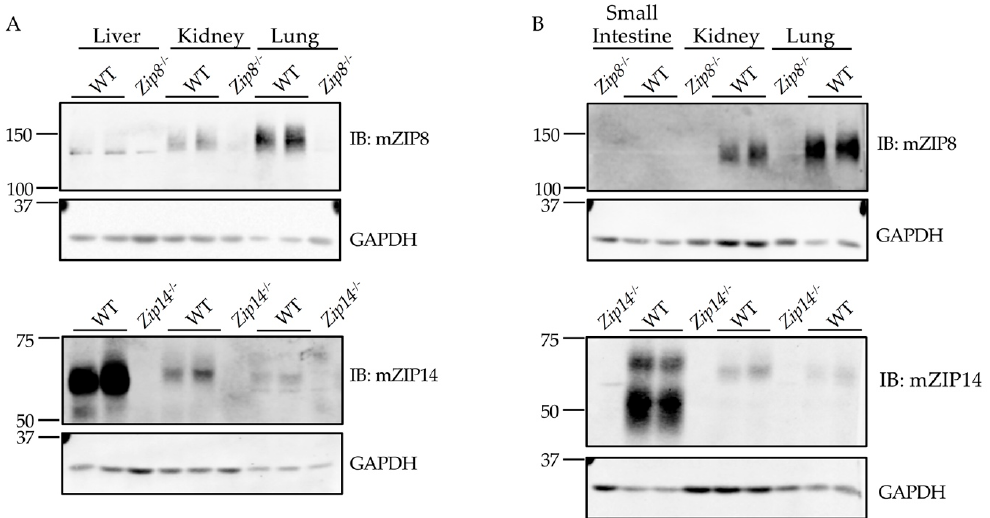
Figure 7. ZIP8 protein is enriched in the lung, but not in the liver or small intestine. The lung, kidney and ( A ) liver or ( B ) small intestine from wild ‐ type (WT) and Zip 8 ‐ / ‐ or Zip 14 ‐ / ‐ mice were homogenized and analyzed by immunoblotting (IB). GAPDH was used as the loading control. The kidney samples were used in both ( A , B ) to serve as a tissue control because both ZIP8 and ZIP14 can be detected in the WT mouse kidney. Our results indicate that ZIP8 protein is highly expressed in the lung, and that ZIP14 is enriched in both the liver and small intestine.